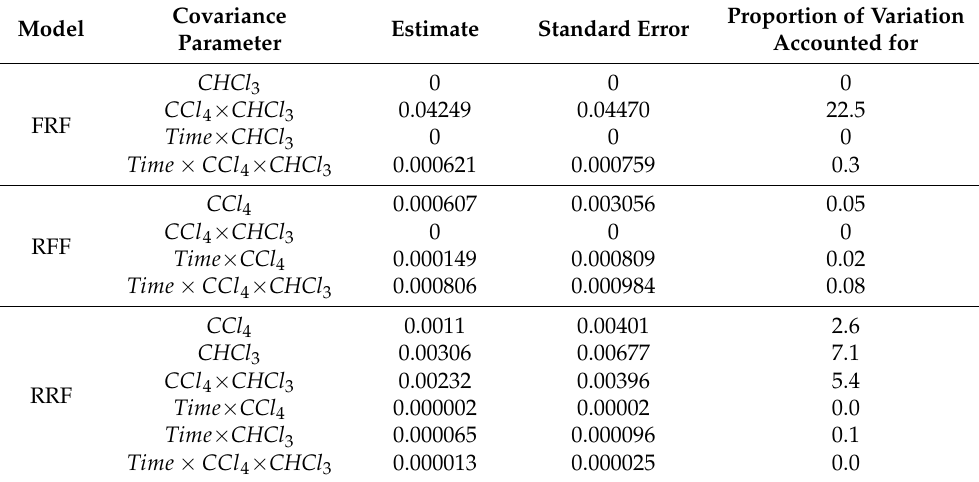
Table 6. Covariance parameter estimates of FRF, RFF, and RRF, models based on ARH(1) covariance